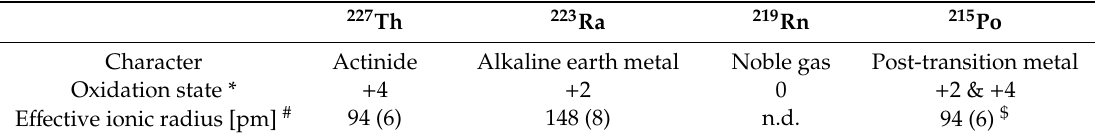
Table 2. Selection of various characteristics demonstrating the striking di ff erences between 227 Th and its first three progenitors in relation to their diverse coordination preferences. 227 Th 223